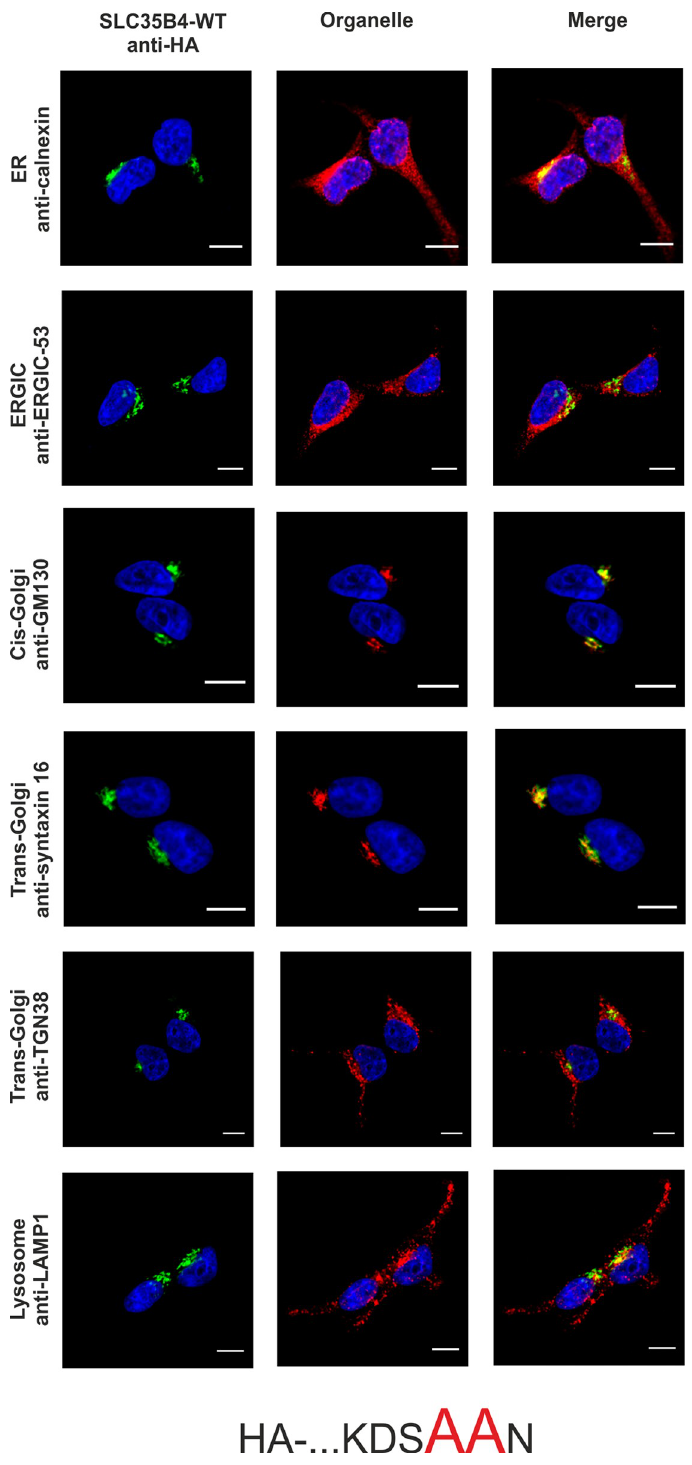
Fig 3. Subcellular localization of HA- ... KDSAAN, human SLC35B4 K329AK330A with HA-epitope at the N- terminus in the wild-type HepG2 cells. Stably transfected wild-type (SLC35B4-WT) cells, overexpressing SLC35B4 variants, were subjected to indirect immunofluorescent staining with anti-HA (green) and anti-organelle markers (Table 3) (red) antibodies. Cell nuclei were counterstained with DAPI. Scale bar 10 μ m.